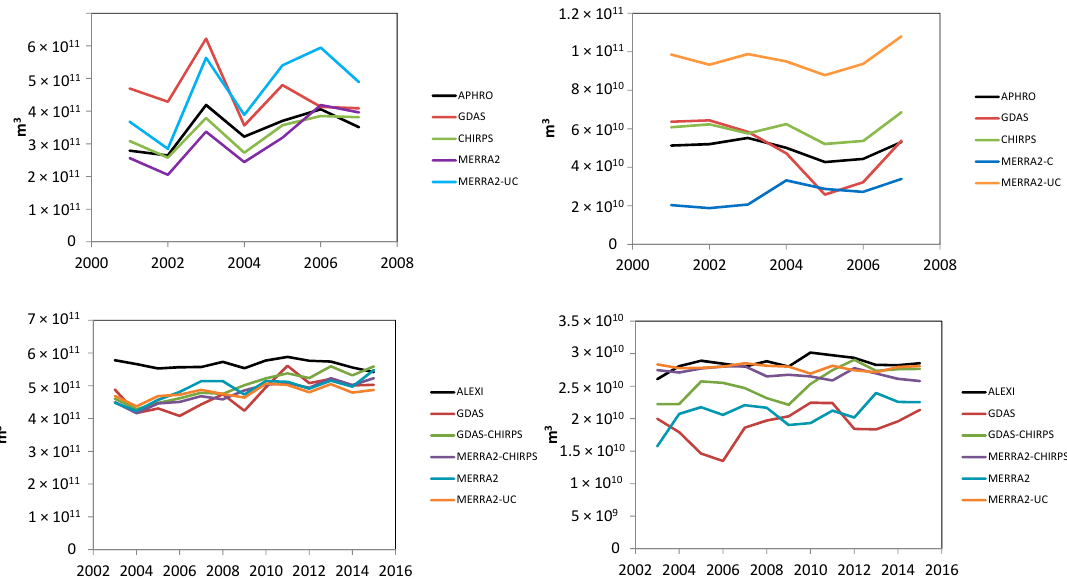
Figure 6. Time series of annual precipitation (m 3 ) ( top-left ) and annual ET (m 3 ) ( bottom-left ) over the Indus river basin. Time series of annual precipitation (m 3 ) ( top-right ) and annual ET (m 3 ) ( bottom-right ) over the Kosi river basin. ET from ALEXI is used for an independent comparison with simulated ET using multiple meteorological forcing (GDAS, GDAS-CHIRPS, MERRA2-CHIRPS, MERRA2, and MERRA2-Uncorrected).